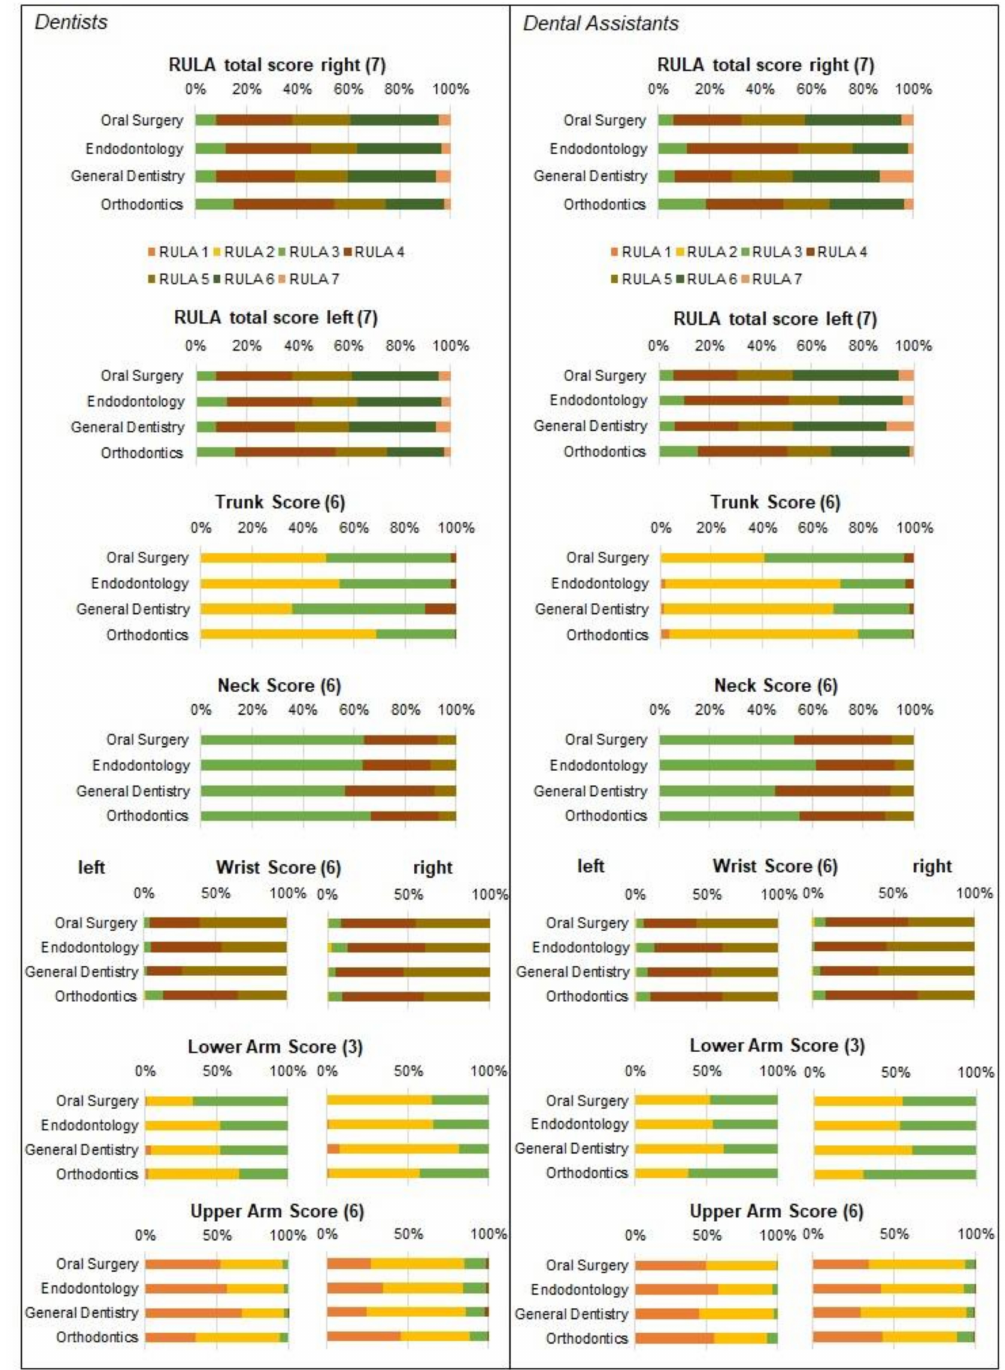
Figure 4. The figure illustrates the relative shares of the different RULA scores for dentists ( left ) and dental assistants ( right ). All subfigures show for each body region the relative shares of the different RULA scores for all four dental fields of dental specialization and use the same color legend, shown under “RULA total score right”. The maximum possible RULA score of each region is specified in